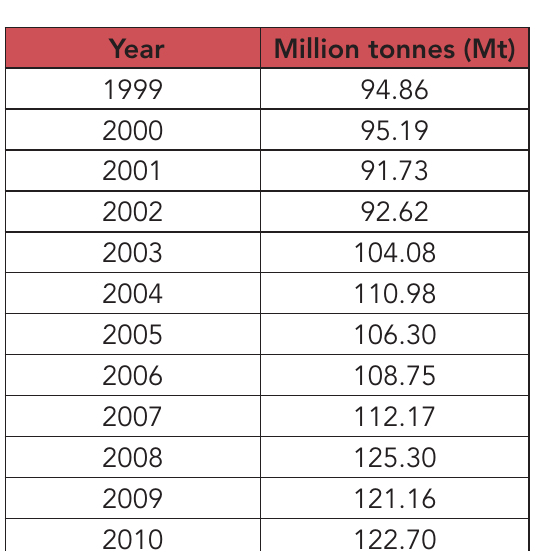
Table 1: Coal consumption by Eskom